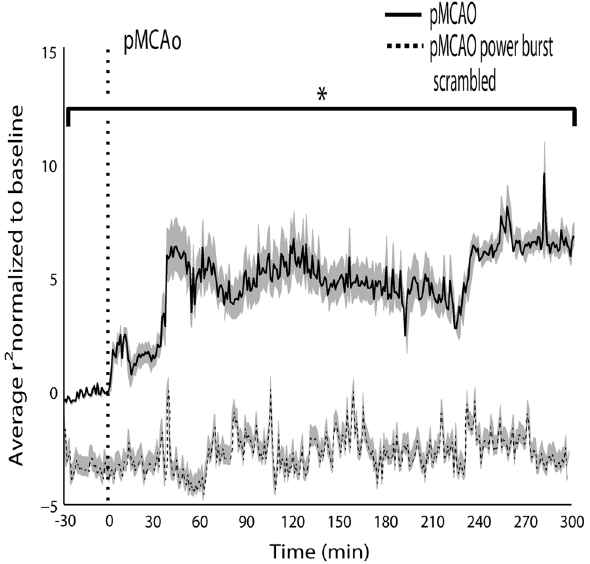
Figure 8. Discrete power burst time points in LFP underlie emergent post pMCAo spatiotemporal synchrony. The solid black line (top, see Fig. 5c) illustrates the average cross-correlation coefficient (baseline normalized) measure that increased directly after pMCAo and was persistently high throughout the acute post pMCAo period (group statistics, pMCAo, n = 7, 95% CI = 5.20, 5.47, Bootstrapped t-statistic comparison to null). The dashed black line (bottom) indicates the resulting average cross-correlation coefficient measure when time points involved in power bursts were scrambled (group statistics, pMCAo scrambled, n = 7, 95% CI = − 0.4,